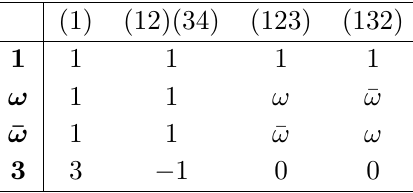
Table 1 . The character table of the A 4 group. A 4 denotes the even permutations of four objects. The conjugacy class (12)(34) represents two inversions carried out in two separate pairs of objects. (123) and (132) represent two inversions carried out in a set of three objects in the forward sense and the backward sense respectively. 1 is the trivial representation. ! and (cid:22) ! are singlets transforming as ! = e i 2 (cid:25) 3 and (cid:22) ! = e (cid:0) i 2 (cid:25) 3 under (123) and (132). 3 represents the three-dimensional rotational symmetries of a regular